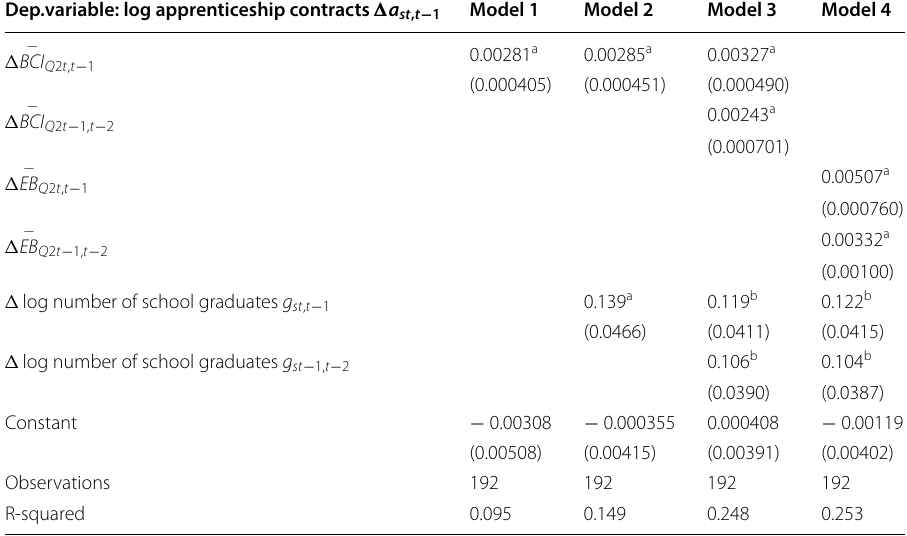
Table 4 First-differences regression, new annual apprenticeship contracts (state-level,